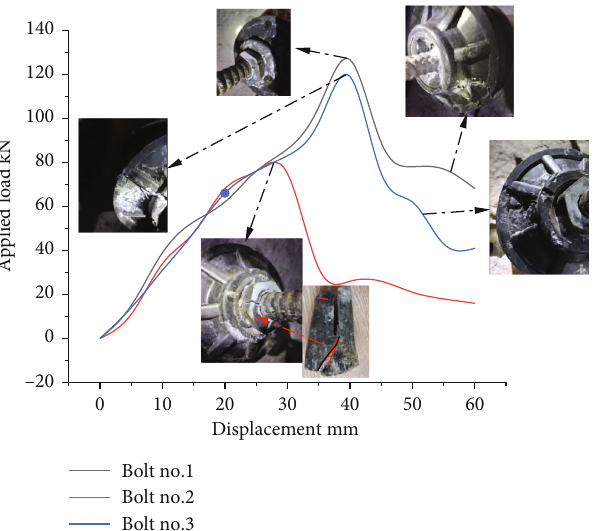
Figure 9: Comparison of pull-out values for di ff erent types of anchor